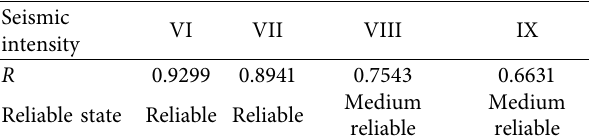
Table 11: The reliability value corresponding to the seismic in- tensity of the road network in the Karamay